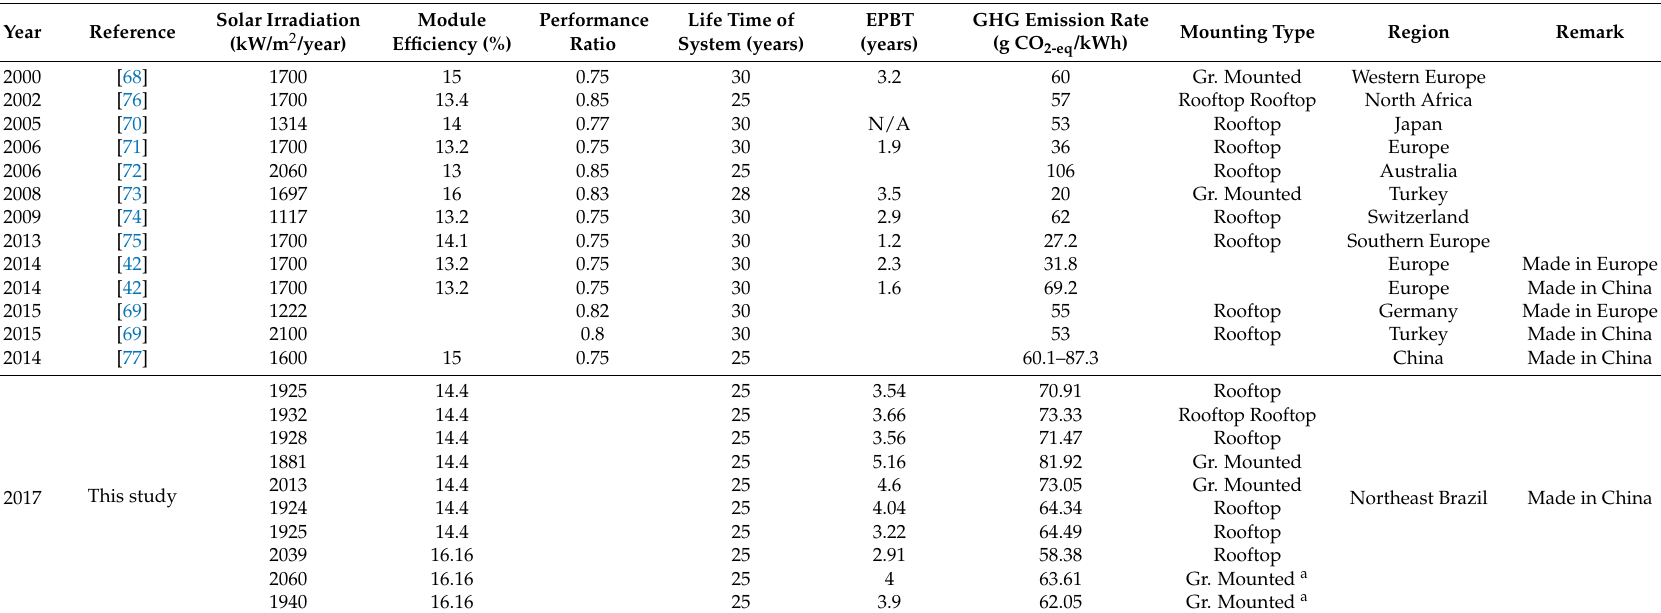
Table 9. Comparative analysis of the results of the present study with previous research. N/A—not